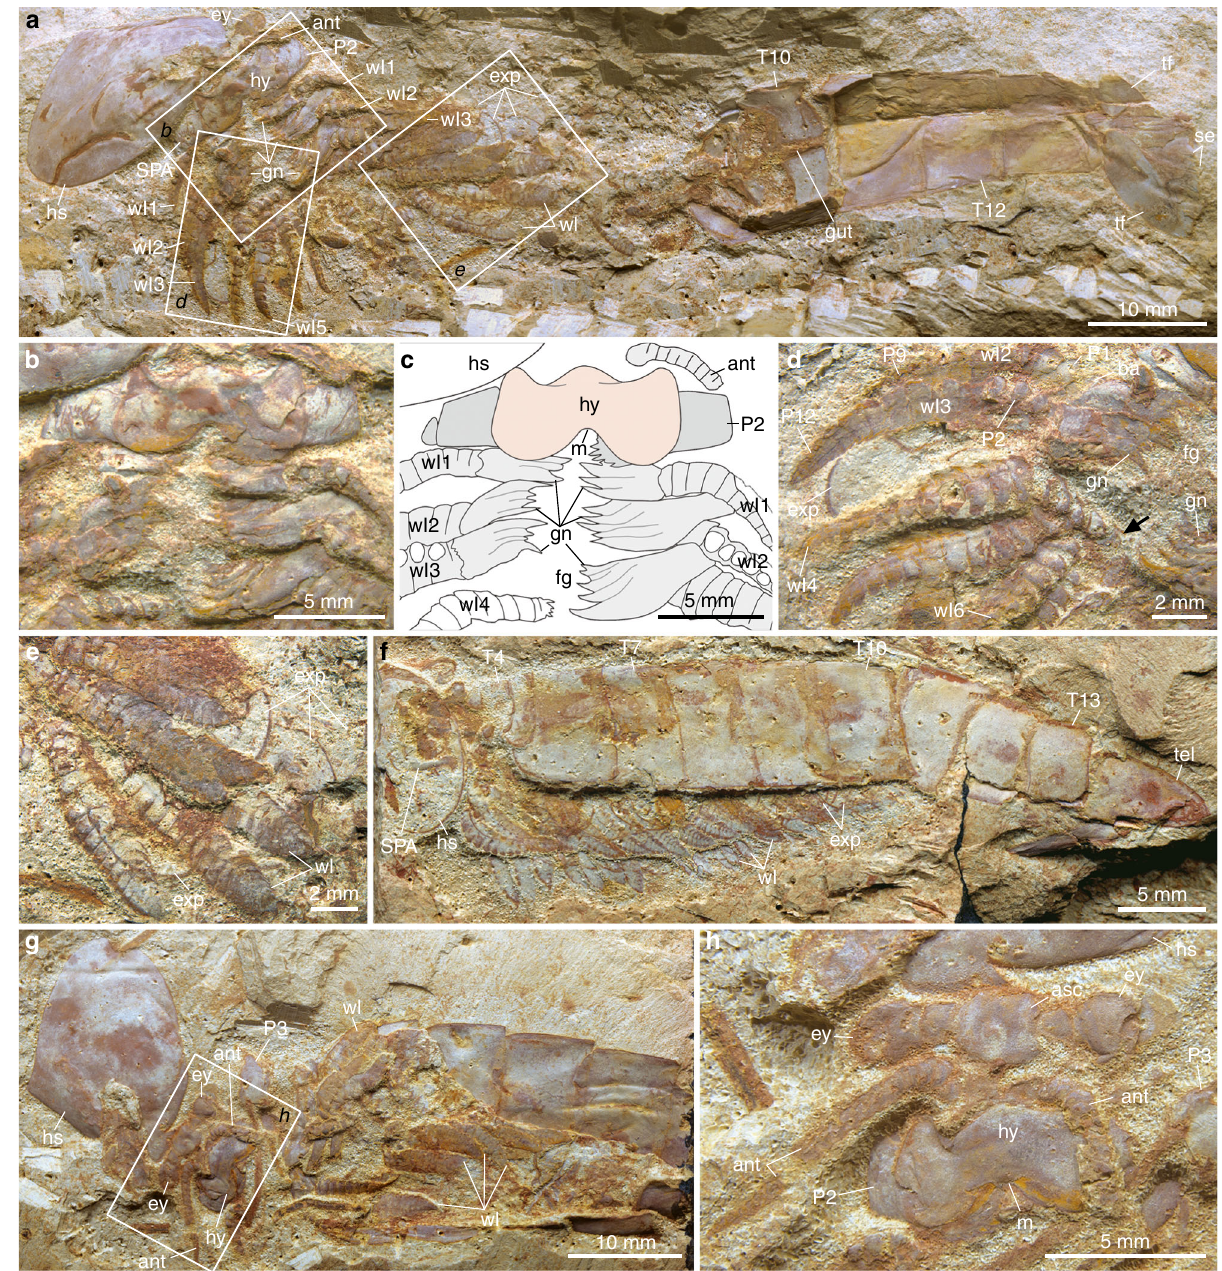
Fig. 1 Alacaris multinoda from the Cambrian (Stage 3) Xiaoshiba Lagerstätte. a – e YKLP 12268 (holotype). a Complete individual in ventral view showing disarticulated head shield, appendicular organization, trunk tergites, and tailspine with paired fl ukes. b Details of area b , showing antennae, hypostome, SPAs, and three sets of walking legs with differentiated gnathobasic protopodites forming a ventral food groove. c Interpretative drawing of b . d Close-up of area d , showing multisegmented endopods with prominent protopodites, followed by walking legs with spinose endites (arrowed). e Close-up of area e , showing multisegmented endopods and fl ap-like exopods. f YKLP 12269, lateral view of a complete individual. g YKLP 12276, specimen with disarticulated head shield, showing organization of the anterior region. h Close-up of area h , showing the anterior sclerite with stalked eyes, the insertion of the paired antennae close to the anterior edge of the hypostome, and the proximal portions of the SPAs. ant: antenna, asc: anterior sclerite, exp: exopod, ey: eye,